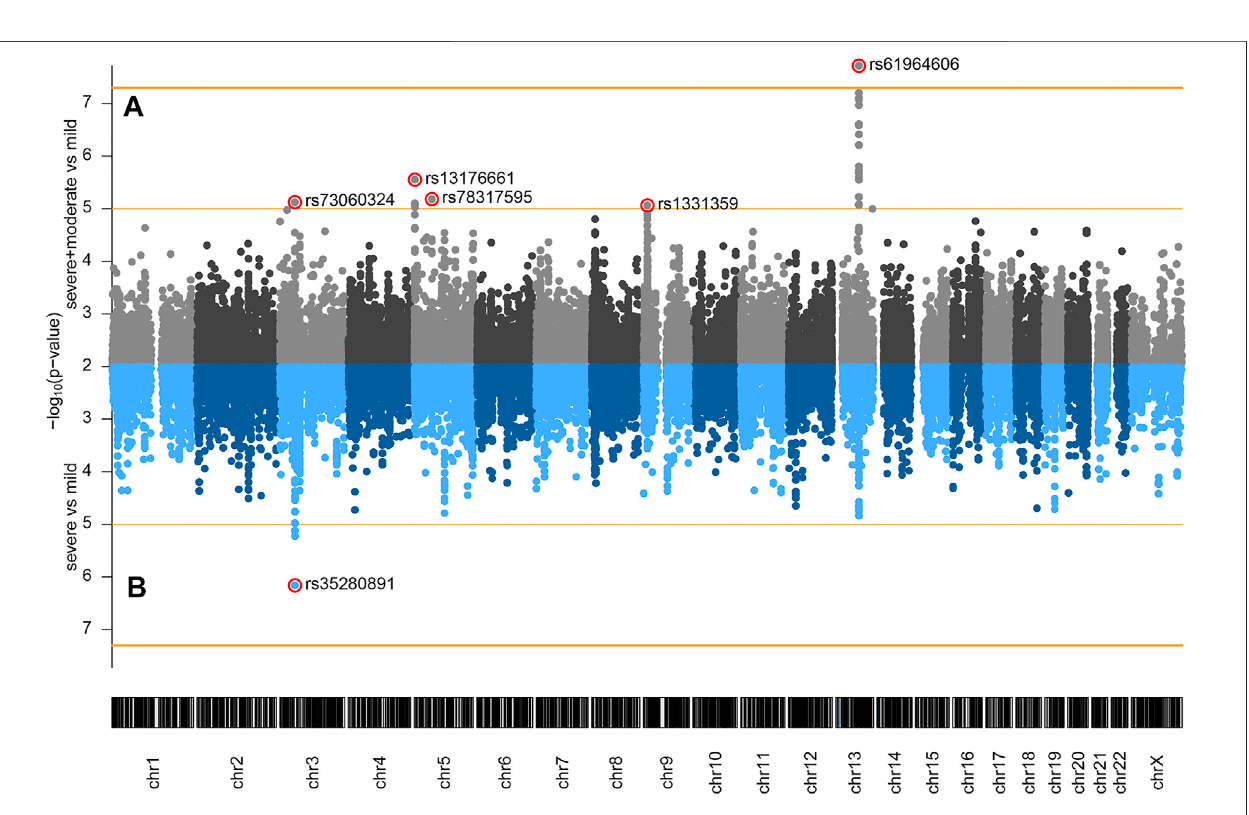
severe groups, including 25%, 52.2%, and 64.7% of male patients, respectively ( p = 0.0009). Patients with severe disease more frequently suffered from diabetes and hypertension ( p = 0.03, p = 0.0015, respectively). CRP level was prominently higher in the